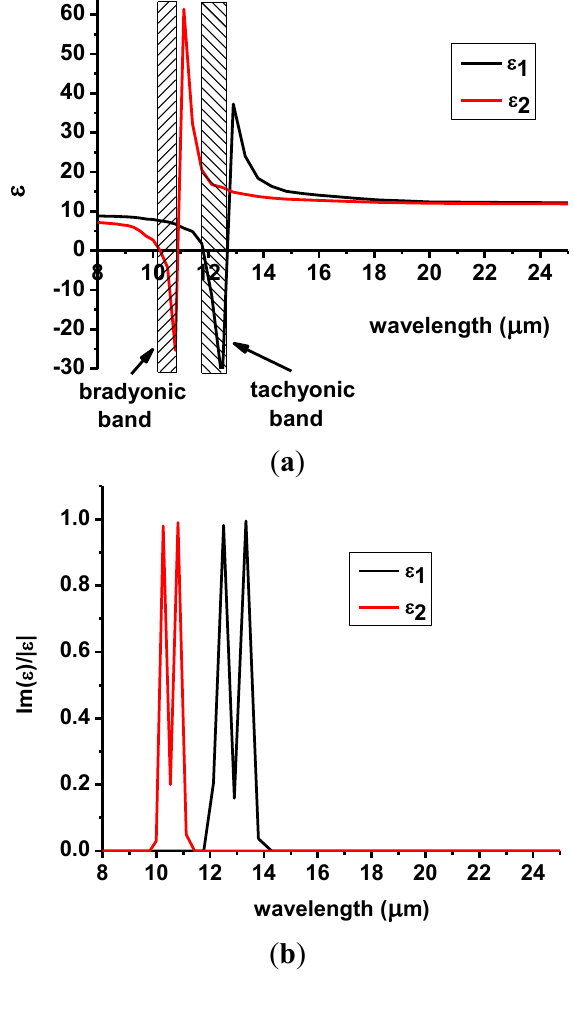
Figure 2. ( a ) Calculated diagonal components of the dielectric permittivity tensor of a multilayer SiC-Si metamaterial in the long wavelength infrared (LWIR) frequency range. The volume fraction of SiC equals n = 0.3. Two closely spaced tachyonic and bradyonic hyperbolic bands arise near λ = 11 μm; ( b ) Calculated Im (ε)/ | ε | for both directions indicate low loss hyperbolic behavior inside the